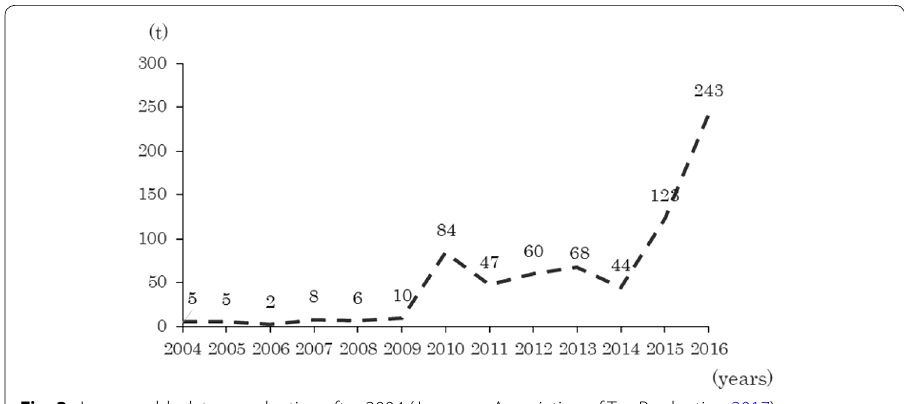
Fig. 3 Japanese black tea production after 2004 (Japanese Association of Tea Production